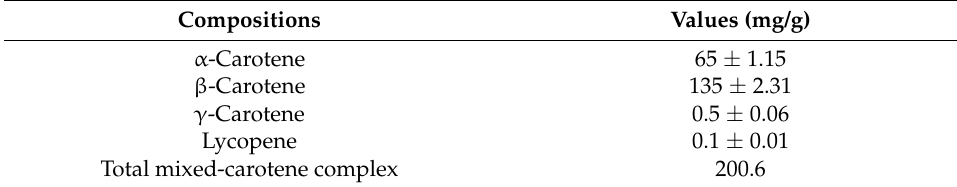
Table 2. Compositions of total mixed-carotene complex 20% oil concentrate